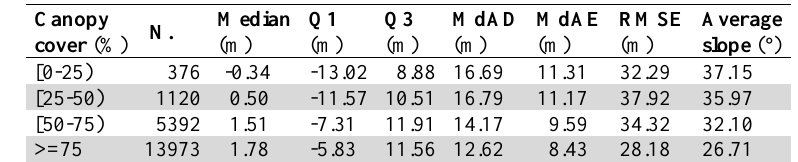
Table. A.1.3 Statistics related to errors from GEDI vs terrain height from discrete lidar divided in canopy cover classes.